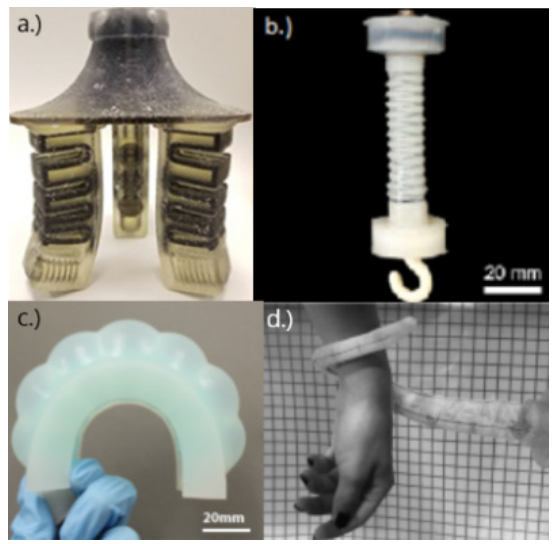
Figure 1. Various soft robots with various actuation methods ( a ) Actuator with multi-material 3D printing [11]. (Open Access); ( b ) Soft linear actuator [12]. (Open Access); ( c ) Design for bidirectional bending [13]. (Copyright 2015, Elsevier); ( d ) Snake-modeled robot [14] (Copyright 2012, Taylor & Francis).